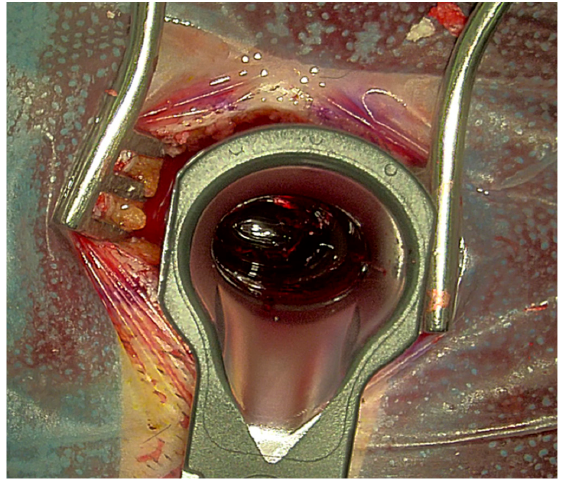
Figure 4. Intraoperative administration of indocyanine green during aneurysm clipping: Perception of indocyanine green during Aeos surgery in A and C. The unclipped aneurysm of the medial cerebral artery is dissected and visualized in ( A ). Visualization of the aneurysm under conventional light during surgery closed with a right-angled Sugita clip in ( B ). In ( C ) the light of the Aeos is on for post clipping control with indocyanine green. Rest perfusion in the clipped sack of the aneurysm at the right angle is highlighted with indocyanine green. Figures ( D – F ) show even enhanced contrast by image processing, which however intraoperativly is not necessary due to high definition backlighted LED screen.